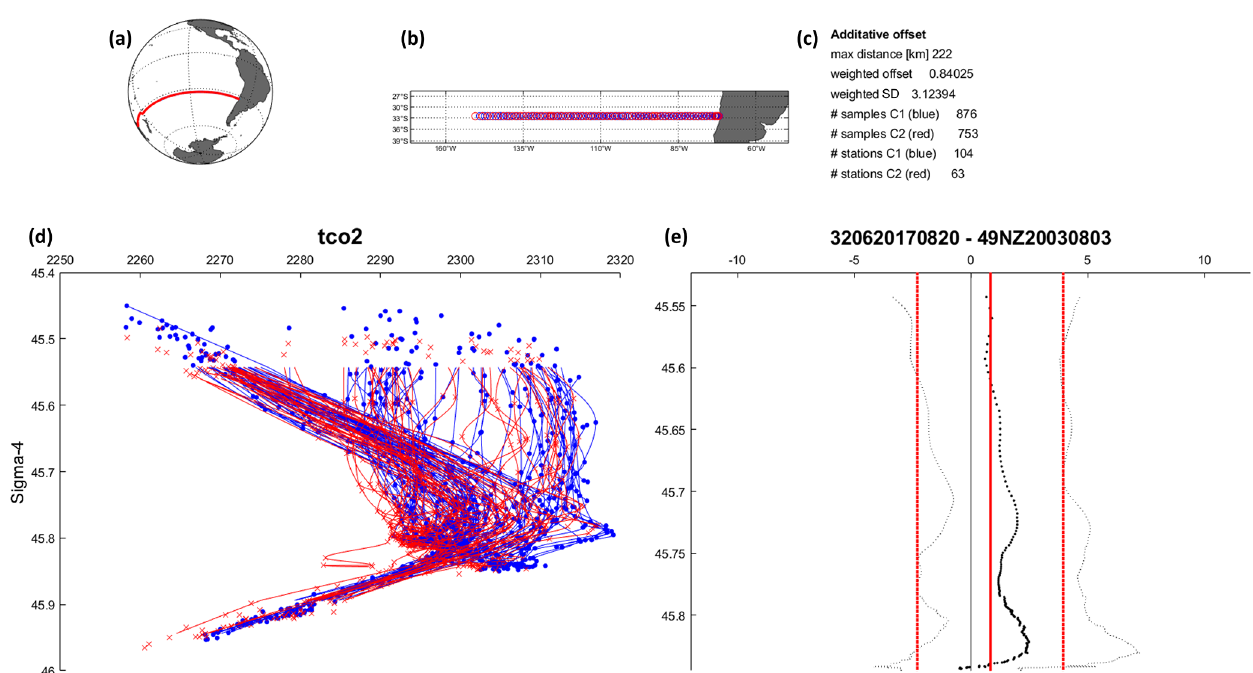
Figure 3. Example crossover figure, for TCO 2 for cruises 320620170820 (blue) and 49NZ20030803 (red), as was generated during the crossover analysis. Panel (a) shows all station positions for the two cruises, and (b) shows the specific stations used for the crossover analysis. Panel (d) shows the data of TCO 2 (µmolkg − 1 ) below the upper depth limit (in this case 2000dbar) versus potential density anomaly referenced to 4000dbar as points and the interpolated profiles as lines. Non-interpolated data either did not meet minimum depth separation requirements (Table 4 in Key et al., 2010) or are the deepest sampling depth. The interpolation does not extrapolate. Panel (e) shows the mean TCO 2 (µmolkg − 1 ) difference profile (black dots) with its standard deviation, as well as also the weighted mean offset (straight red lines) and weighted standard deviation. Summary statistics are provided in (c)